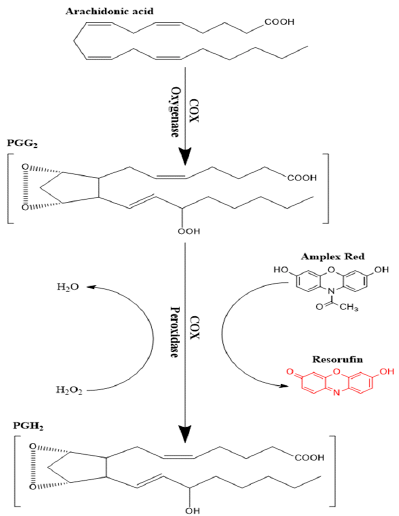
Figure 2. Schematic presentation of the peroxidase activity assay of cyclooxygenase (COX) enzymes. Peroxidation of arachidonic acid by BV2 cell lysates was inhibited by selective COX inhibitors such as KPF by 90.41 ± 4.6% and IC50 value of 0.85 ± 1.18 µM (Figure 3). Similarly, LAT1-utilizing pro-drugs 2, 3, and 4 (PD2-4) inhibited the peroxidation by (85.32 ± 3.27%, IC50 = 1.05 ± 1.21 µM), (79.89 ± 1.77%, IC50 = 2.26 ± 1.33 µM), and (90.25 ± 3.58%, IC50 = 0.58 ± 1.22 µM), respectively. In contrast, PD1 was not able to inhibit the peroxidation as efficiently as the KPF and the other LAT1-utilizing pro-drugs, even at higher concentrations up to 40 µM.